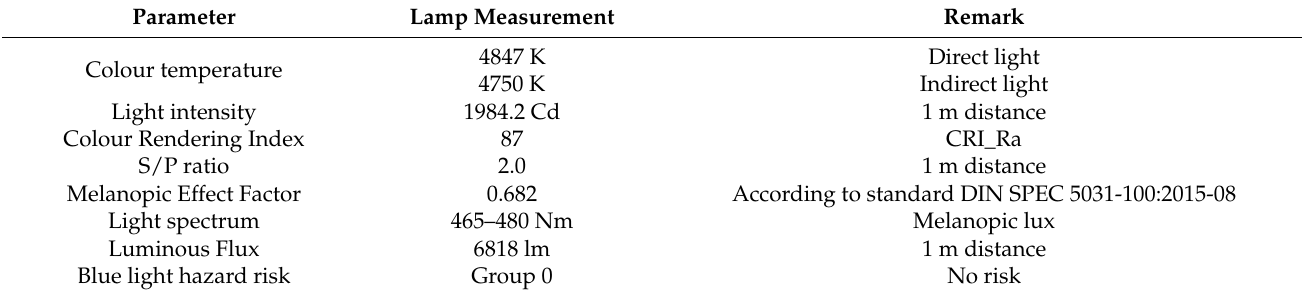
Figure 4. ( a ) Spectrum analysis of BDL; ( b ) Spectrum analysis of placebo light. Table 2. Measurement data of one lamp from Olino measurement